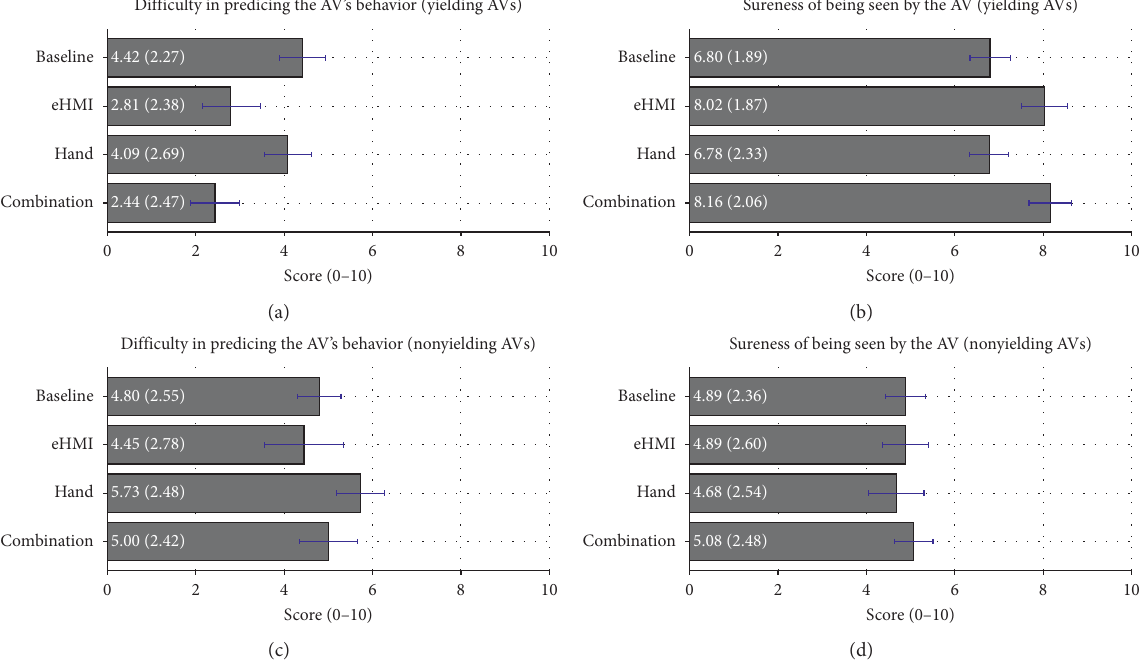
Figure 5: Mean responses to posttrial questions, distinguishing between yielding and nonyielding AVs. Error bars represent 95% confidence intervals (computed according to [35]). Also shown are the means (standard deviations across participants in parentheses) in numeric form. n � 26, except for the Combination condition in a and b , where n � 25, because 1 participant never raised the hand.